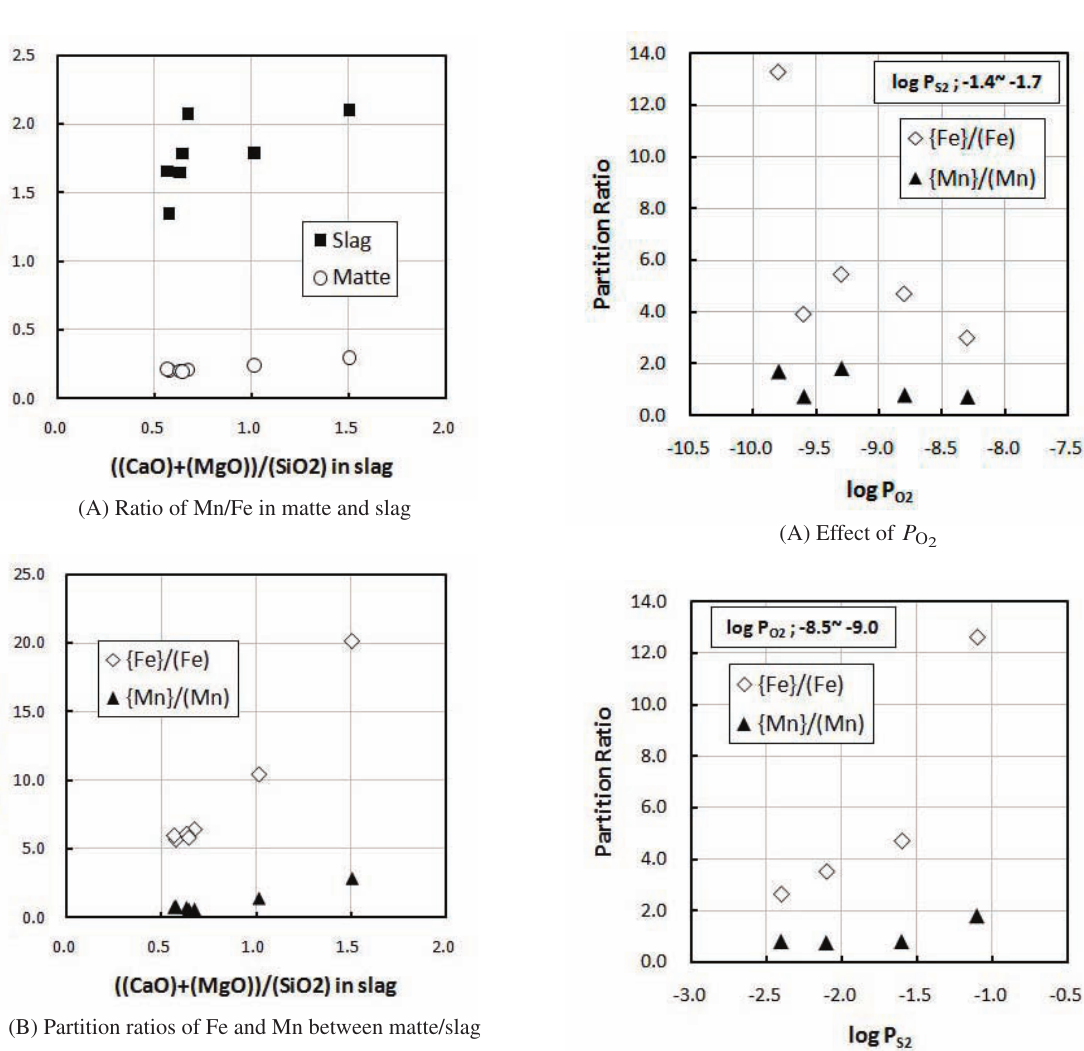
Figure 10. Effects of P O Fe and Mn between matte/molten